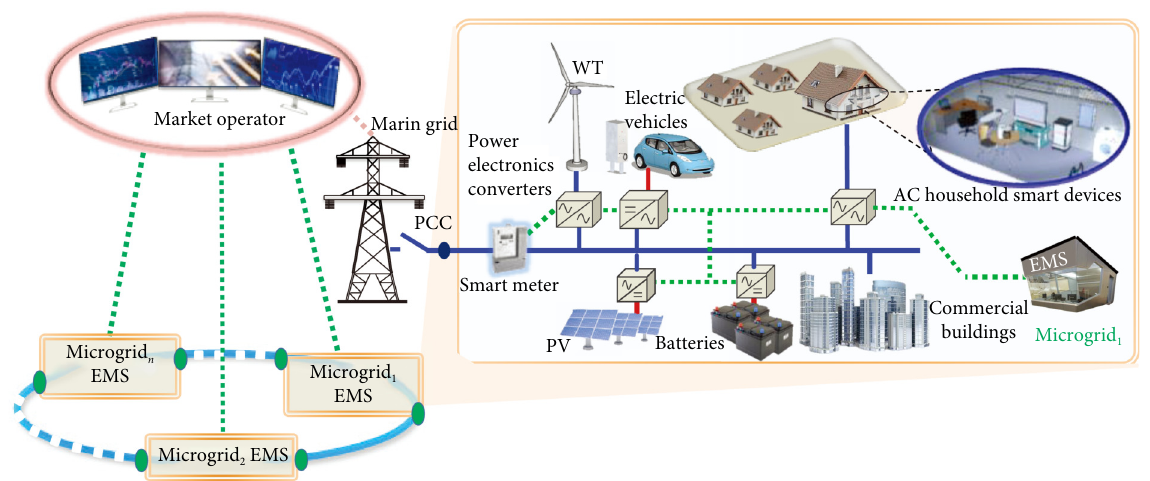
Fig. 5 Cooperative power dispatching for